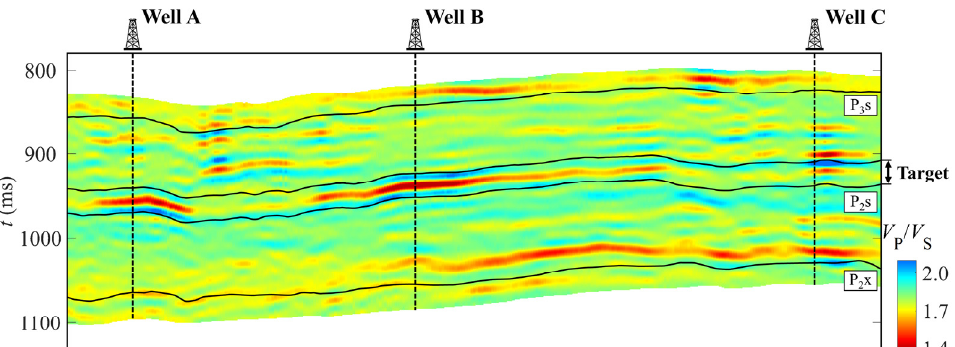
Figure 13. Seismic section of V P / V S across wells A, B, and C.